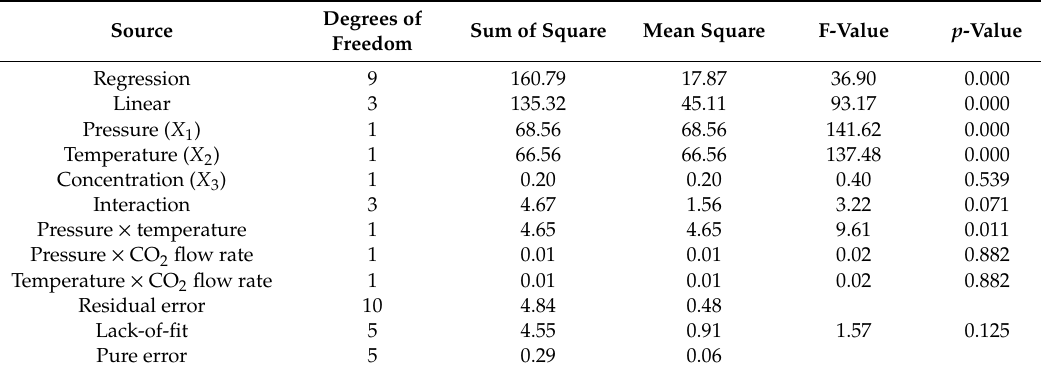
Table 3. Analysis of variance of the experimental